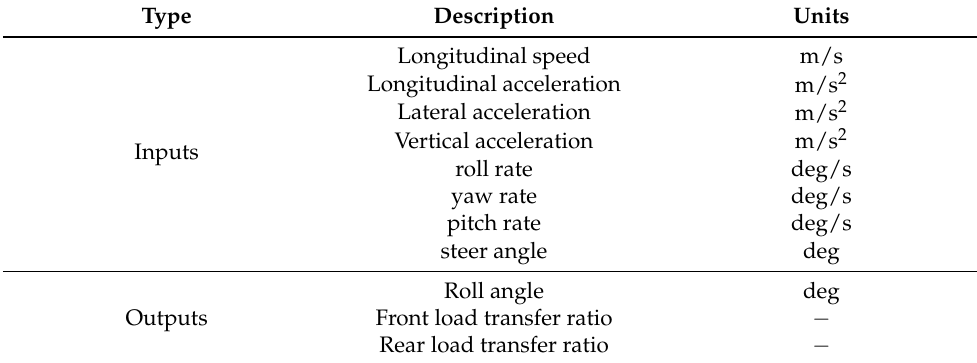
Table 2. RNN: inputs and outputs.